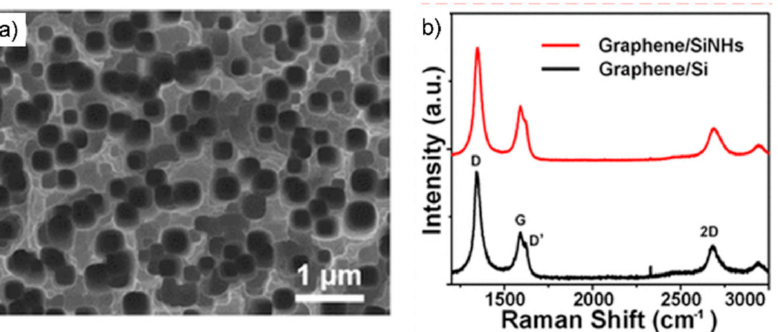
Figure 5. ( a ) SEM image of the conformal graphene/SiNHs structure; ( b ) Raman spectra of graphene on SiNHs (red) and Si (black); ( a , b ) Reproduced with permission from [108]. Copyright American Chemical Society, 2019.